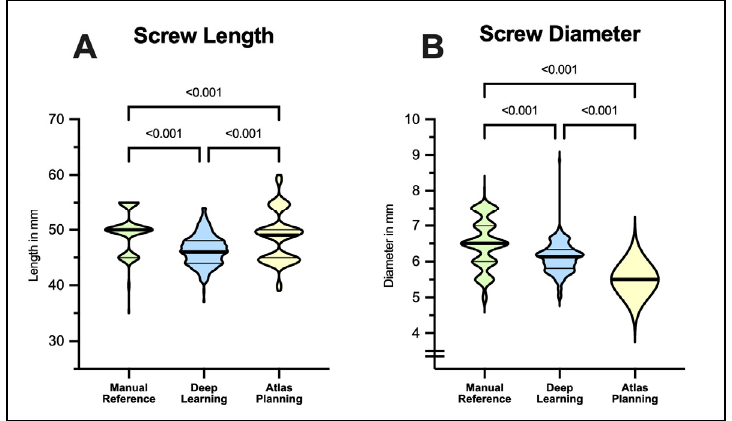
Figure 2. Performance of deep-learning- and atlas-based tools in comparison to manual screw planning by spine surgery experts. Violin plots illustrate proposed values for screw length ( A ) and screw diameter ( B ). In atlas-based planning, screw diameter was set to 5.5 mm by default in all cases analyzed. Note the reduced success in atlas-based planning (208/256 screws, 81%) available for analysis. Statistical significance was tested with Kruskal–Wallis tests followed by Dunn’s post-test for multiple comparisons.